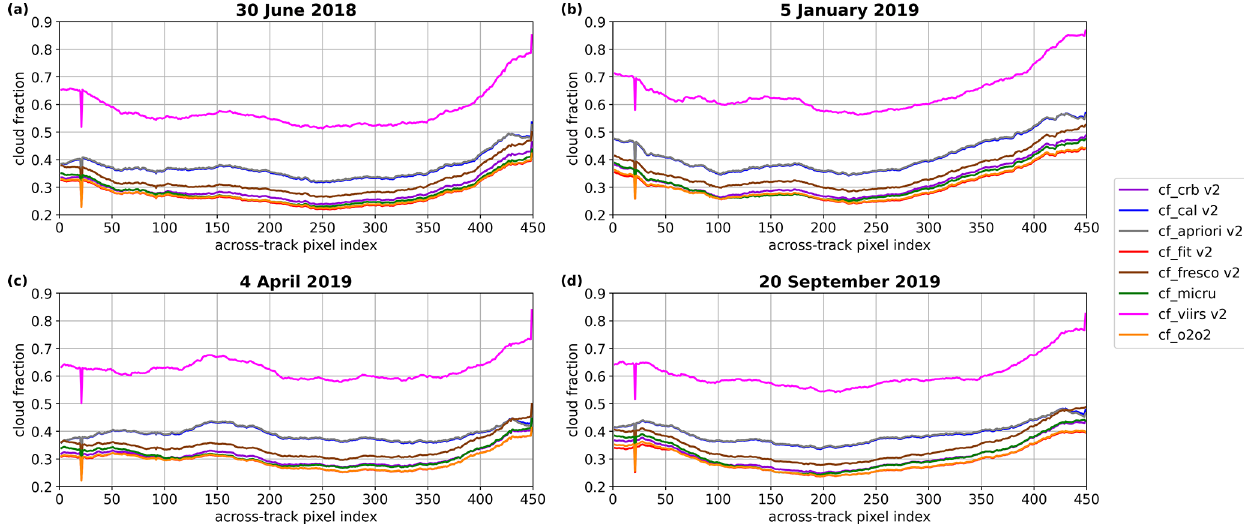
Figure 16. Mean values of version 2 cloud fractions, as a function of the across-track index, from ROCINN CRB, ROCINN CAL, OCRA a priori, the NO 2 fitting window (cf_fit), FRESCO, MICRU, VIIRS, and O 2 –O 2 for the globe and (a) the summer day, (b) the winter day, (c) the spring day, and (d) the autumn day with quality, snow, and ice flagging and only including pixels that have valid values for all products.